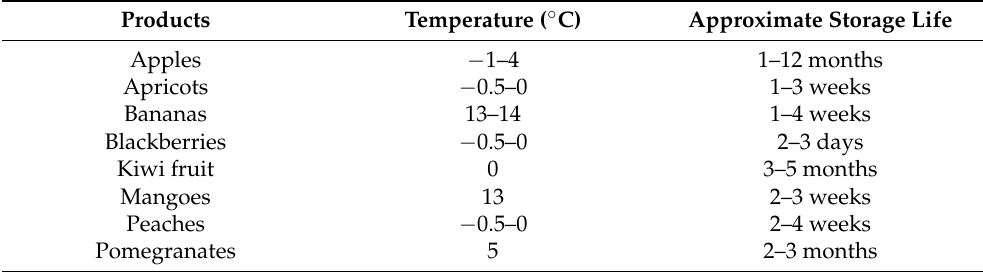
Table 2. Temperature and approximate storage life of perishable fruits refrigeration.